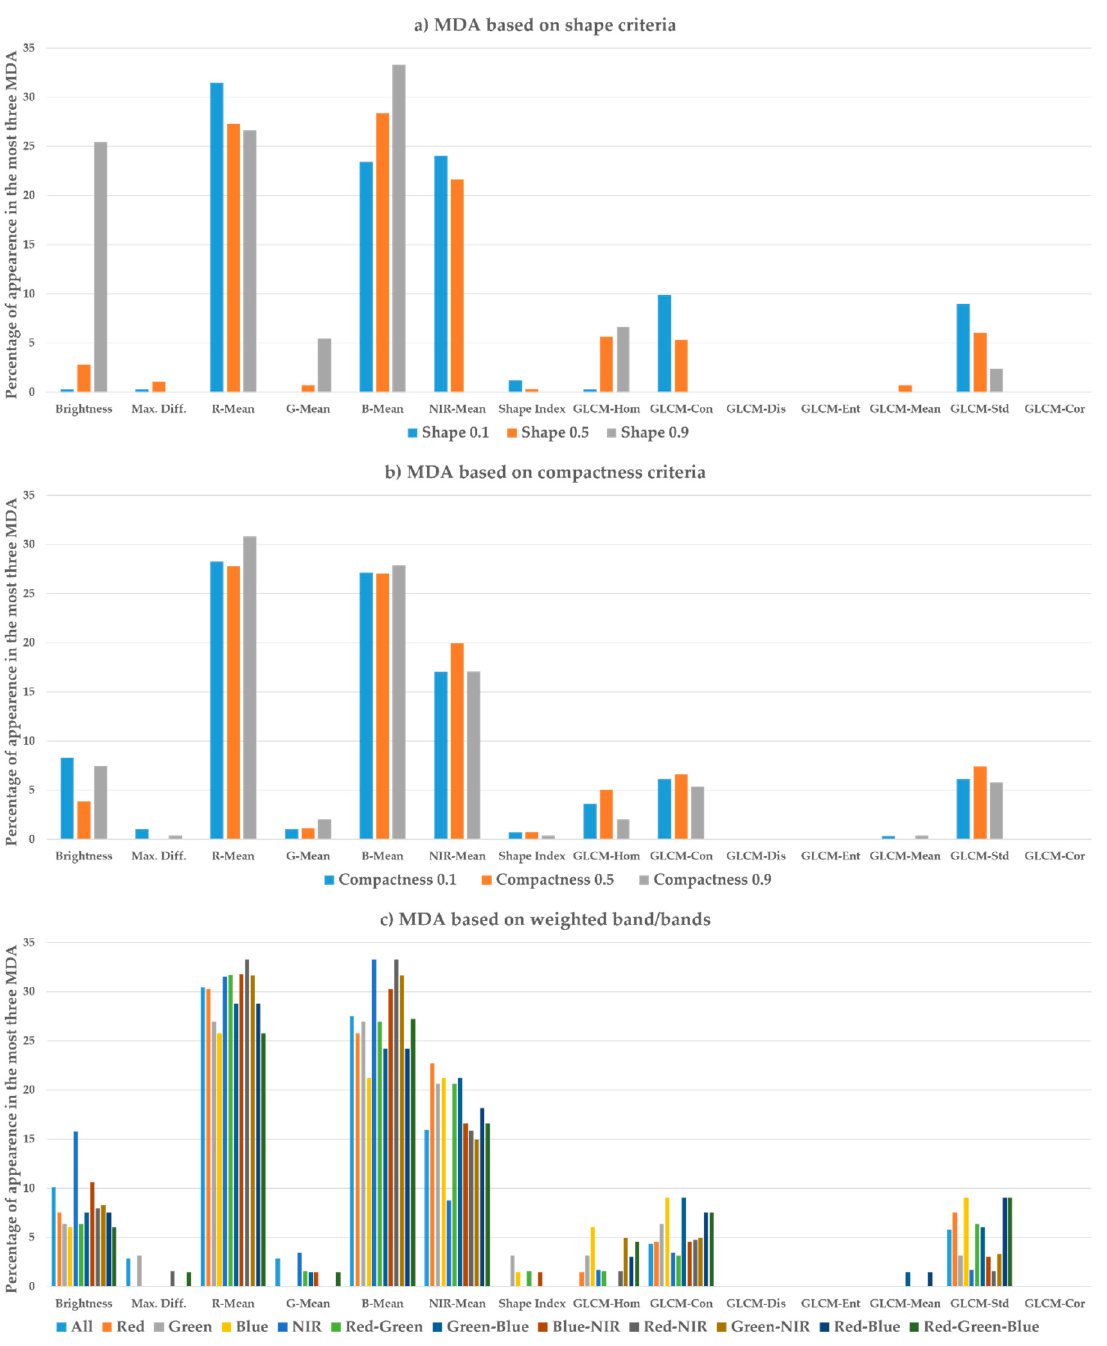
Figure 14. Mean decrease accuracy for variables.